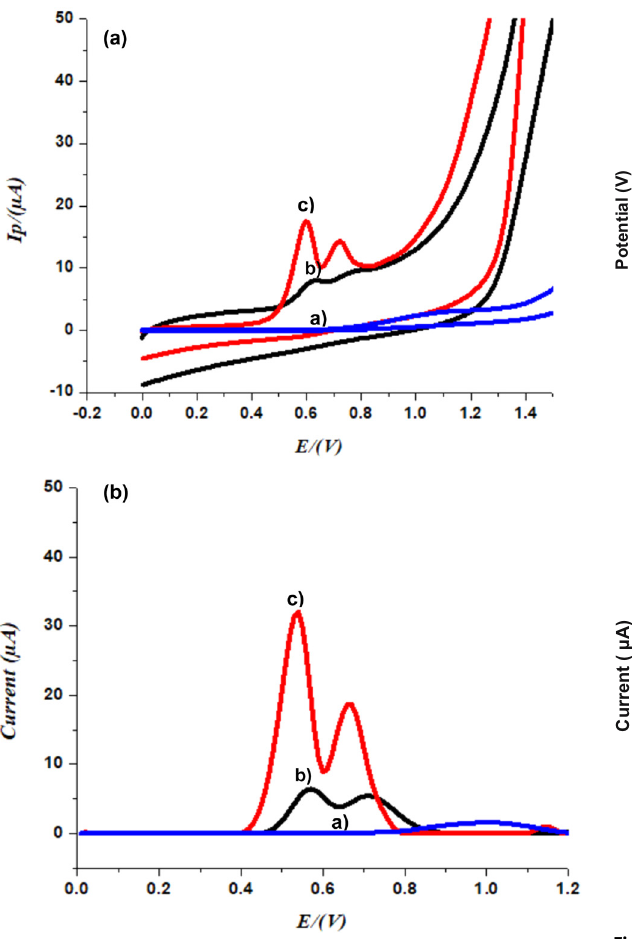
Figure 1: ( a ) Cyclic voltammograms and ( b ) square wave voltam - mograms of 1.0 × 10 − 4 M SUL in BRB ( pH 10.0 ) : ( a ) bare DE, ( b ) bare GCE, ( c ) bare PGE.